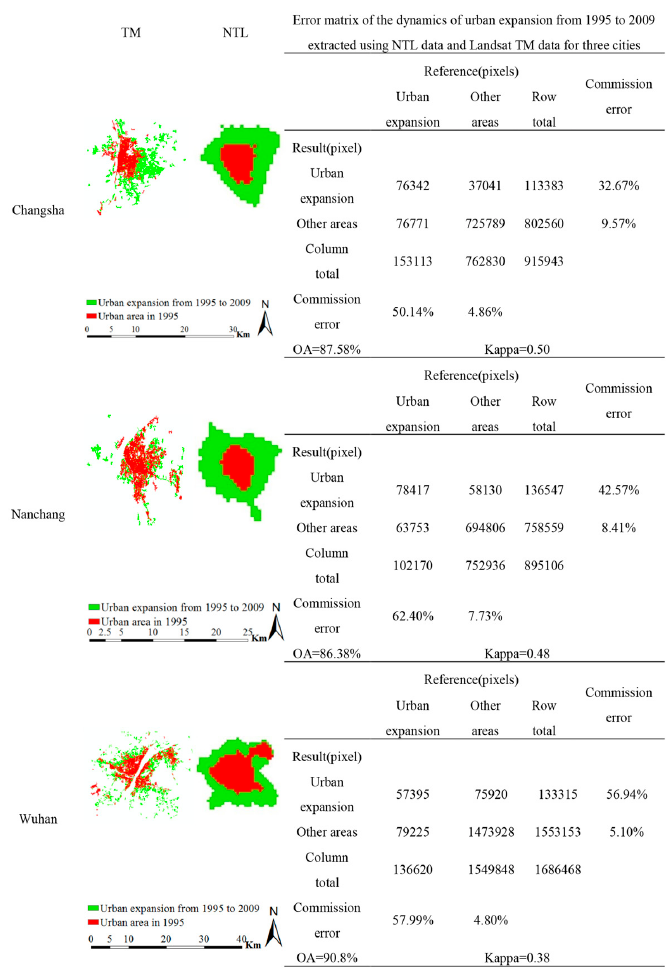
Figure 6. Accuracy assessment of urban expansion in provincial capital cities from 1995 to 2009.